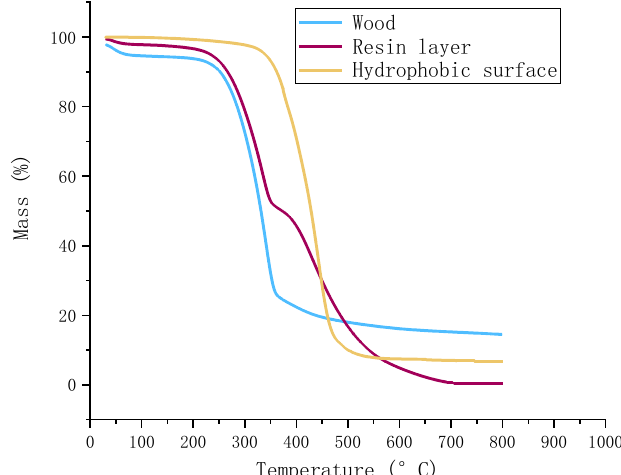
Figure 8. X-ray diffraction pattern of untreated wood samples, resin layer, and hydrophobic surface on wood.